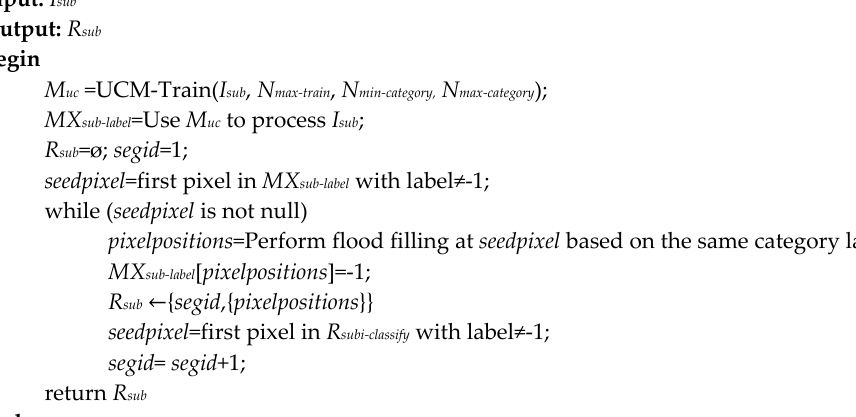
Algorithm 3 : Subimage segmentation by a deep neural network